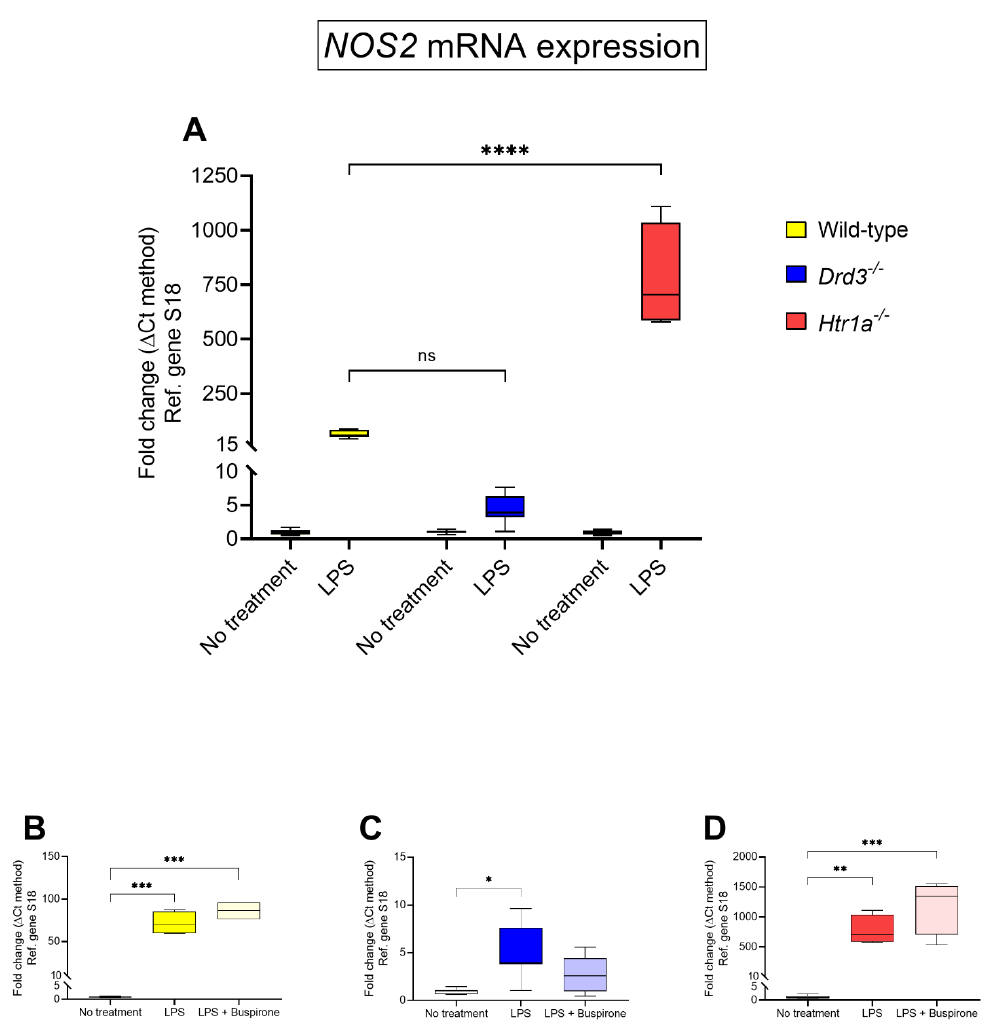
Figure 4. NOS2 mRNA expression following exposure to LPS and treatment with buspirone for 24 h. Gene expression was measured using real-time qPCR and quantified using the ∆∆ Ct method after normalization to the S18 housekeeping gene. ( A ) Box and whisker plots showing the differential expression of NOS2 transcripts in untreated or LPS-treated wild type, Drd3 −/− and Htr1a −/− cells or after co-treatment of ( B ) wild type, ( C ) Drd3 −/− and ( D ) Htr1a −/− cells with LPS in combination with buspirone. All the amplifications were performed using selected primers optimised for qPCR analyses (<155 bp length) which recognise fragments within the coding sequence of the gene of interest (for details please refer to Table 4). Results are presented as mean fold changes with respect to no treatment (control) ± SEM. Fold changes of each gene were obtained after normalisation to the endogenous reference gene. Baseline levels of no treatment groups were set to 1. Statistically significant data (* p < 0.05, ** p < 0.01, *** p < 0.001, **** p < 0.0001) were determined by one-way or two-way ANOVA followed by Tukey and Dunnett’s post-hoc tests. Ns = not significant.